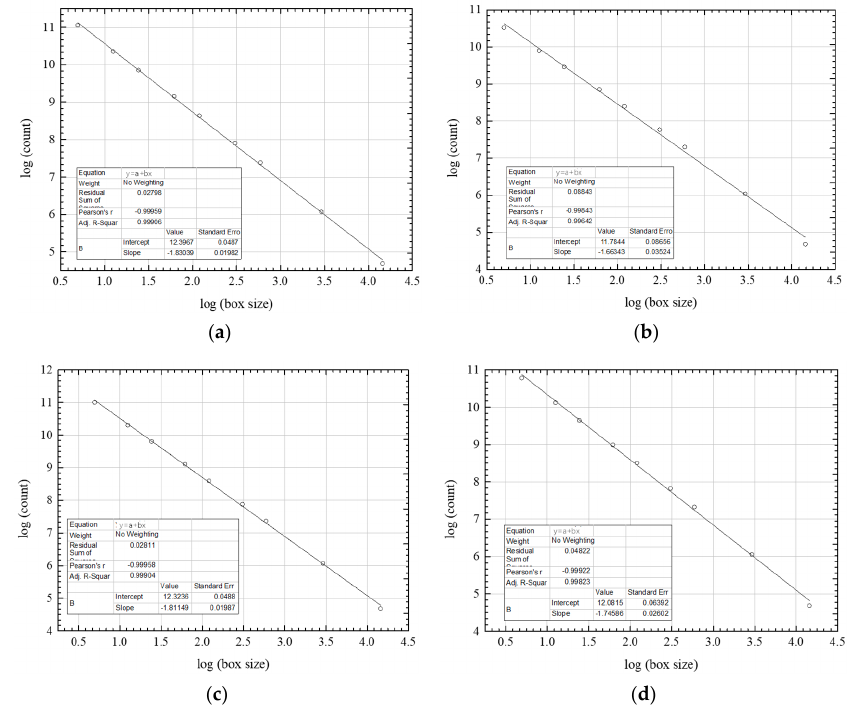
Figure 11. Accuracy of fractal dimension: ( a ) NAC-10,000; ( b ) CSAC10,000; ( c ) NAC-20,000; ( d ) CSAC-20,000. The fractal dimension can be used as a parameter to characterize the roughness of concrete cross-sections. Accordingly, the correlation coefficients shown in Table 12 are all above 0.99, indicating that the cross-section of the concrete SEM images had fractal char- acteristics. These results are nearly identical to the findings of [40,41]. Fractal dimension calculations have shown that the roughness of specimens increases with increases in the fractal dimension at the same amplification ratio [42]. In this study, the fractal dimension of the SEM section of the copper slag aggregate concrete was smaller than that of the nat- ural aggregate concrete, indicating that the addition of the copper slag aggregate pro- moted decreases in the initial damage to the internal section of the concrete. These results lead to the conclusion that the strength and durability of copper slag aggregate concrete are superior to those of natural aggregate concrete. Table 12. Results of fractal dimension. Species